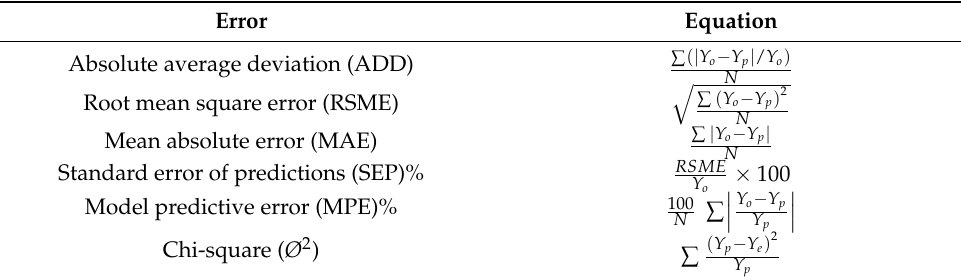
Table 3. Equations of statistical